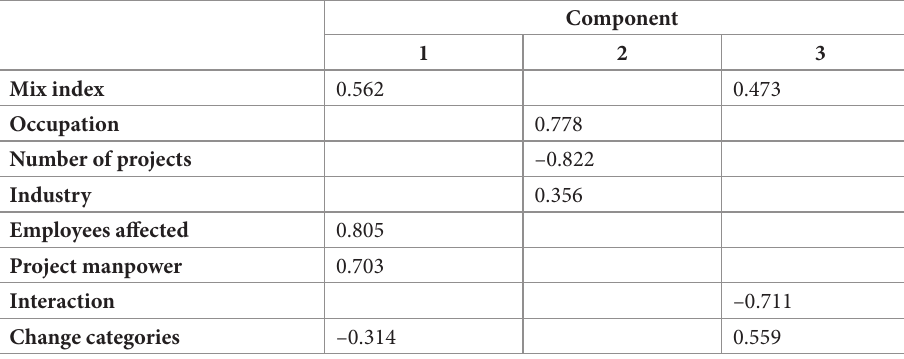
Table 4. Component diagram (rotated component